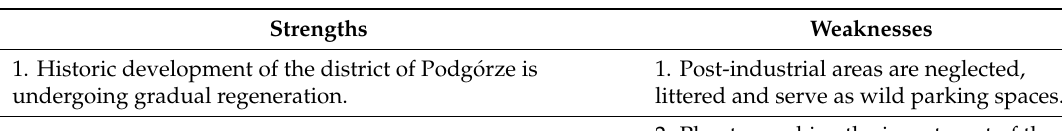
Table 3. SWOT analysis concerning the conditions of the existing project-related area (table by E.